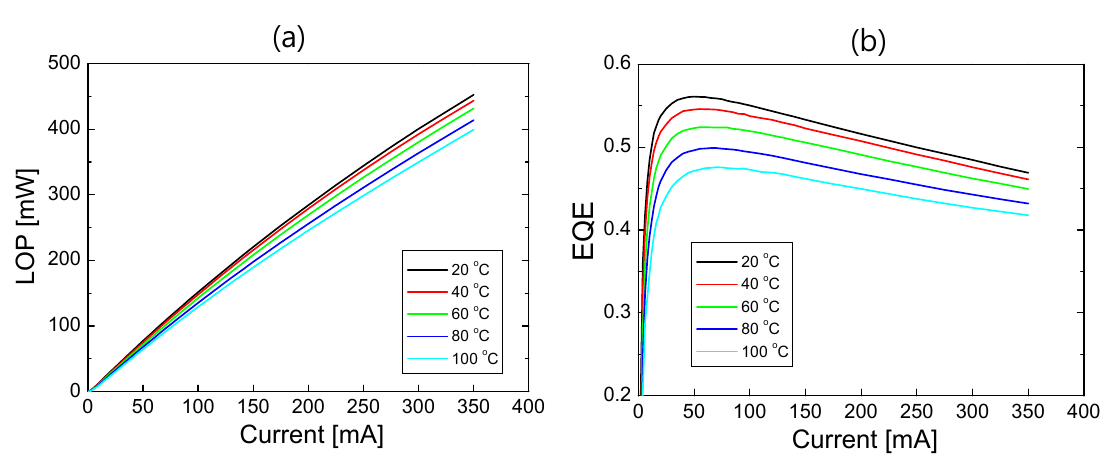
Figure 1. ( a ) Light output power (LOP) and ( b ) external quantum efficiency (EQE) of the measured LED sample as a function of injection current at temperatures of 20, 40, 60, 80, 100 °C.